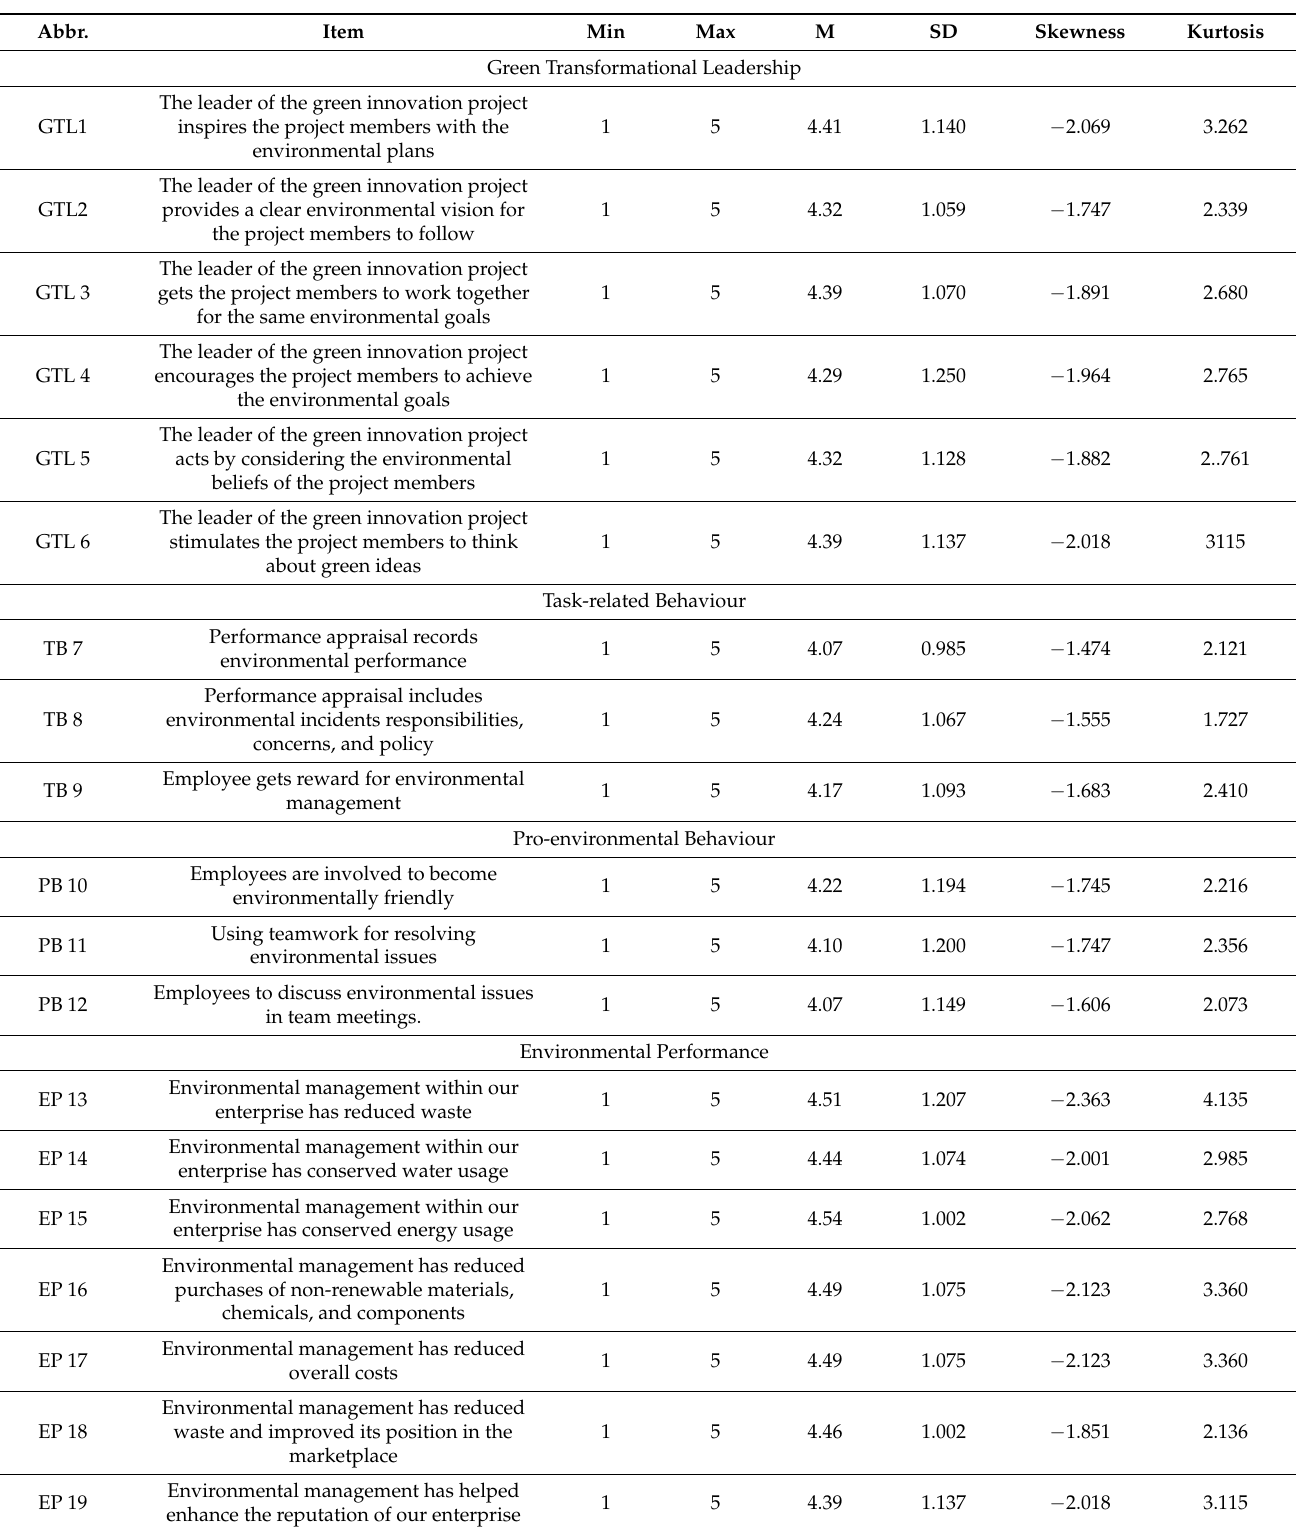
Table 2. Descriptive statistics (developed by authors based on previous